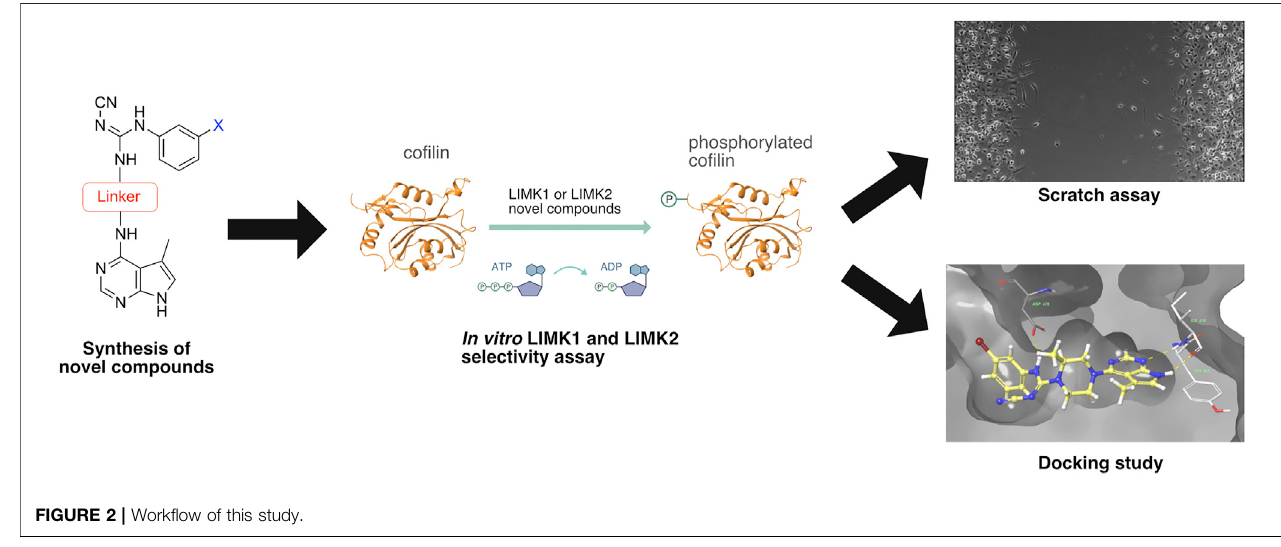
FIGURE 2 | Work fl ow of this